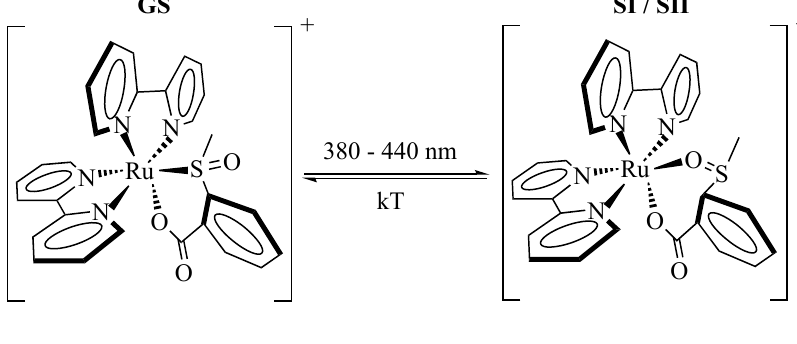
Figure 4. Scheme of the light-induced isomerization for [Ru(bpy) state GS (left) to the metastable states SI/SII (right). For simplicity the metastable states are only depicted as one state in this